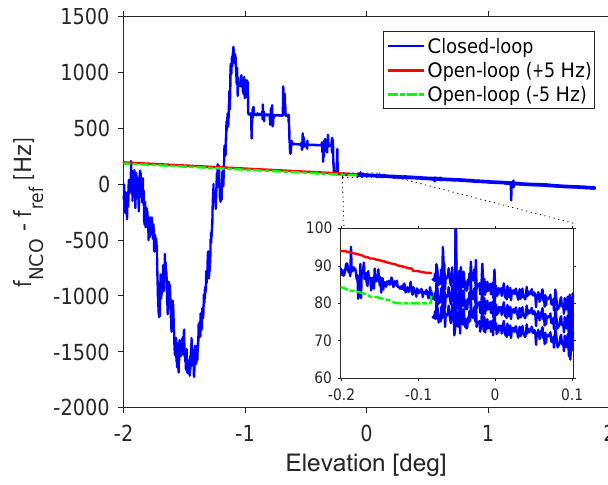
Figure 3. Carrier NCO frequency as a function of geometric satel- lite elevation angle. For clarity, a constant frequency value of f ref = 1 . 4071MHz is subtracted. The transition between closed-loop and open-loop tracking is depicted in the insert highlighting the 10Hz offset between the two O/L channels. Same event as shown in Fig.